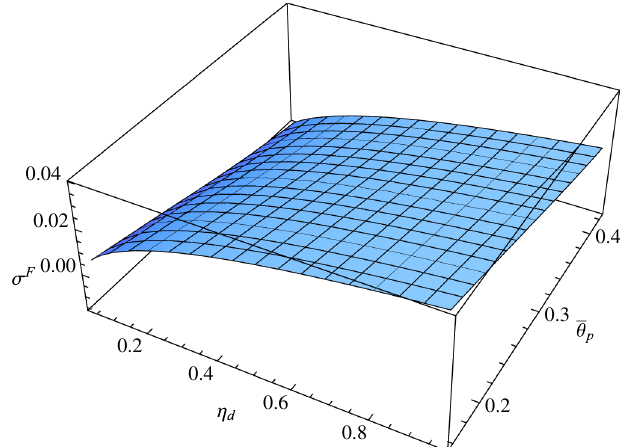
FIG. 6. Relative difference between the analytic and simulated ¼ 0 . fits for (cid:5) (cid:3)